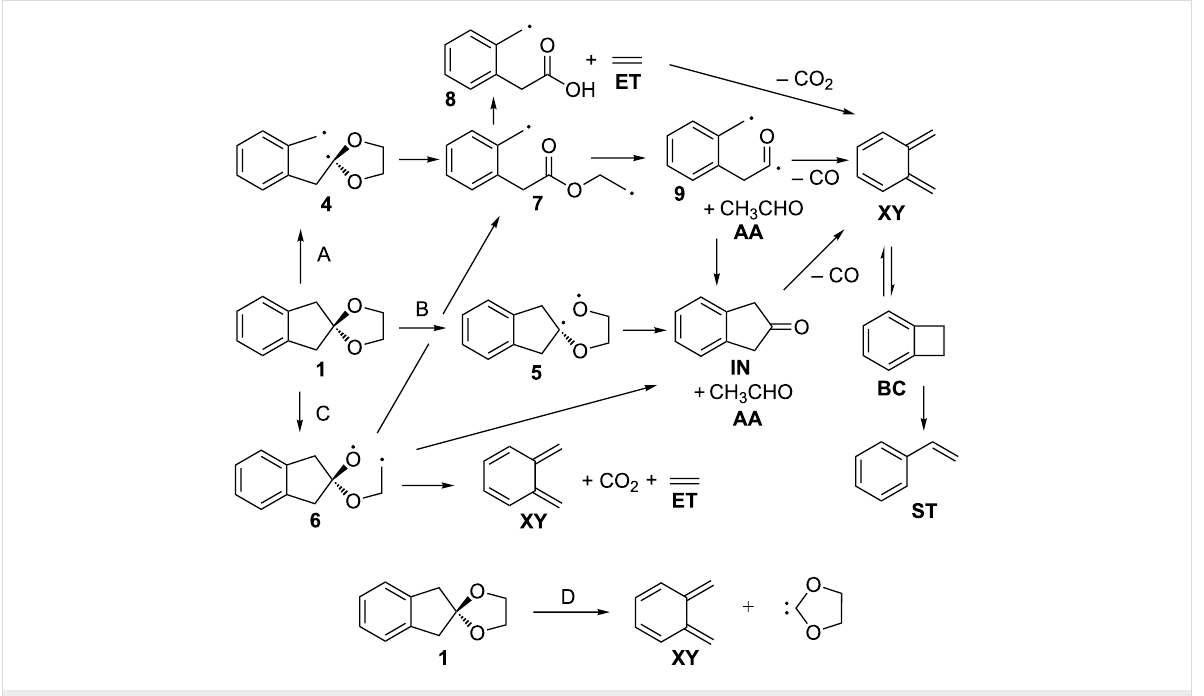
Scheme 4: Possible fragmentation pathways in the FVP of 1